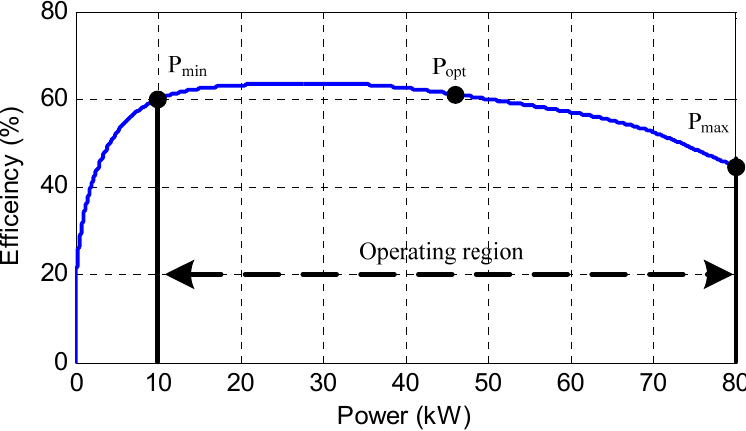
Figure 8. Relationship between FCS efficiency and